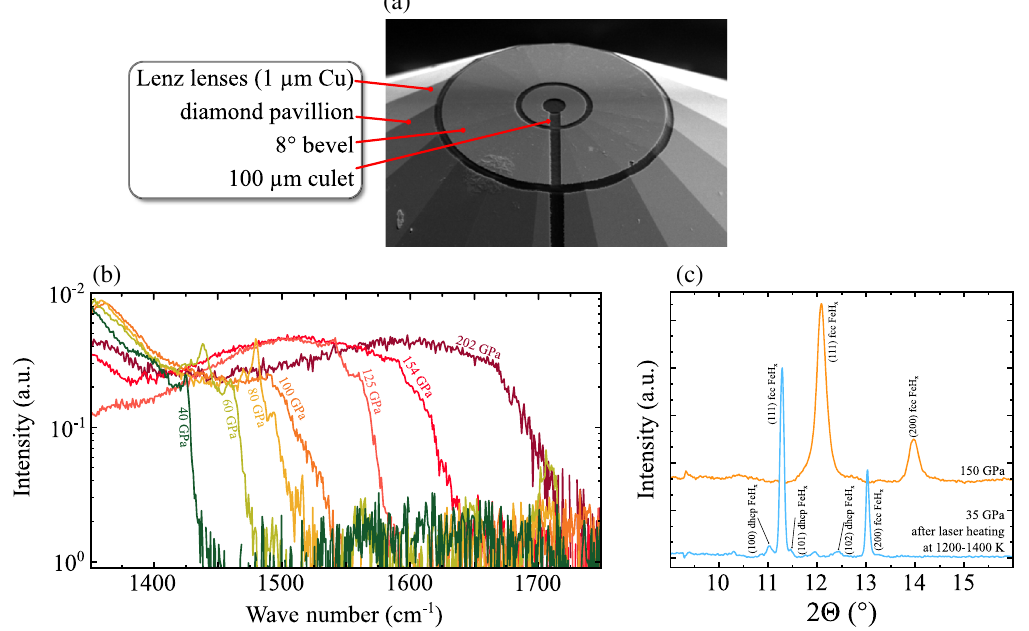
FIG. 1. (a) SEM image of the NMR Lenz lens resonator structure deposited and formed on the surface of a 100 - μ m diamond anvil, (b) Raman spectra of the diamond edge at the center of the 100 - μ m culets used for pressure calibration, and (c) x-ray diffraction patterns after sample synthesis (laser heating) at 35 GPa (blue line) and after compression to 150 GPa (orange